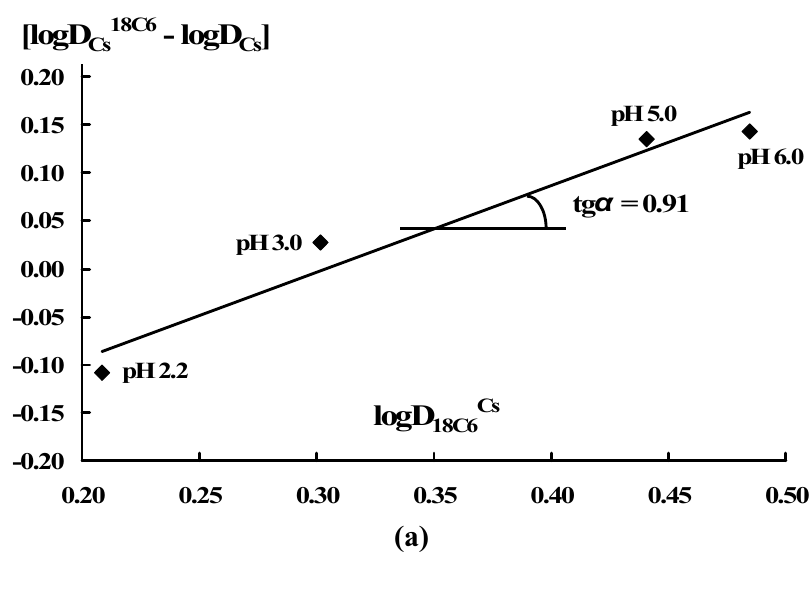
Figure 4. Plots of [logD CsCE – logD (b) CE =